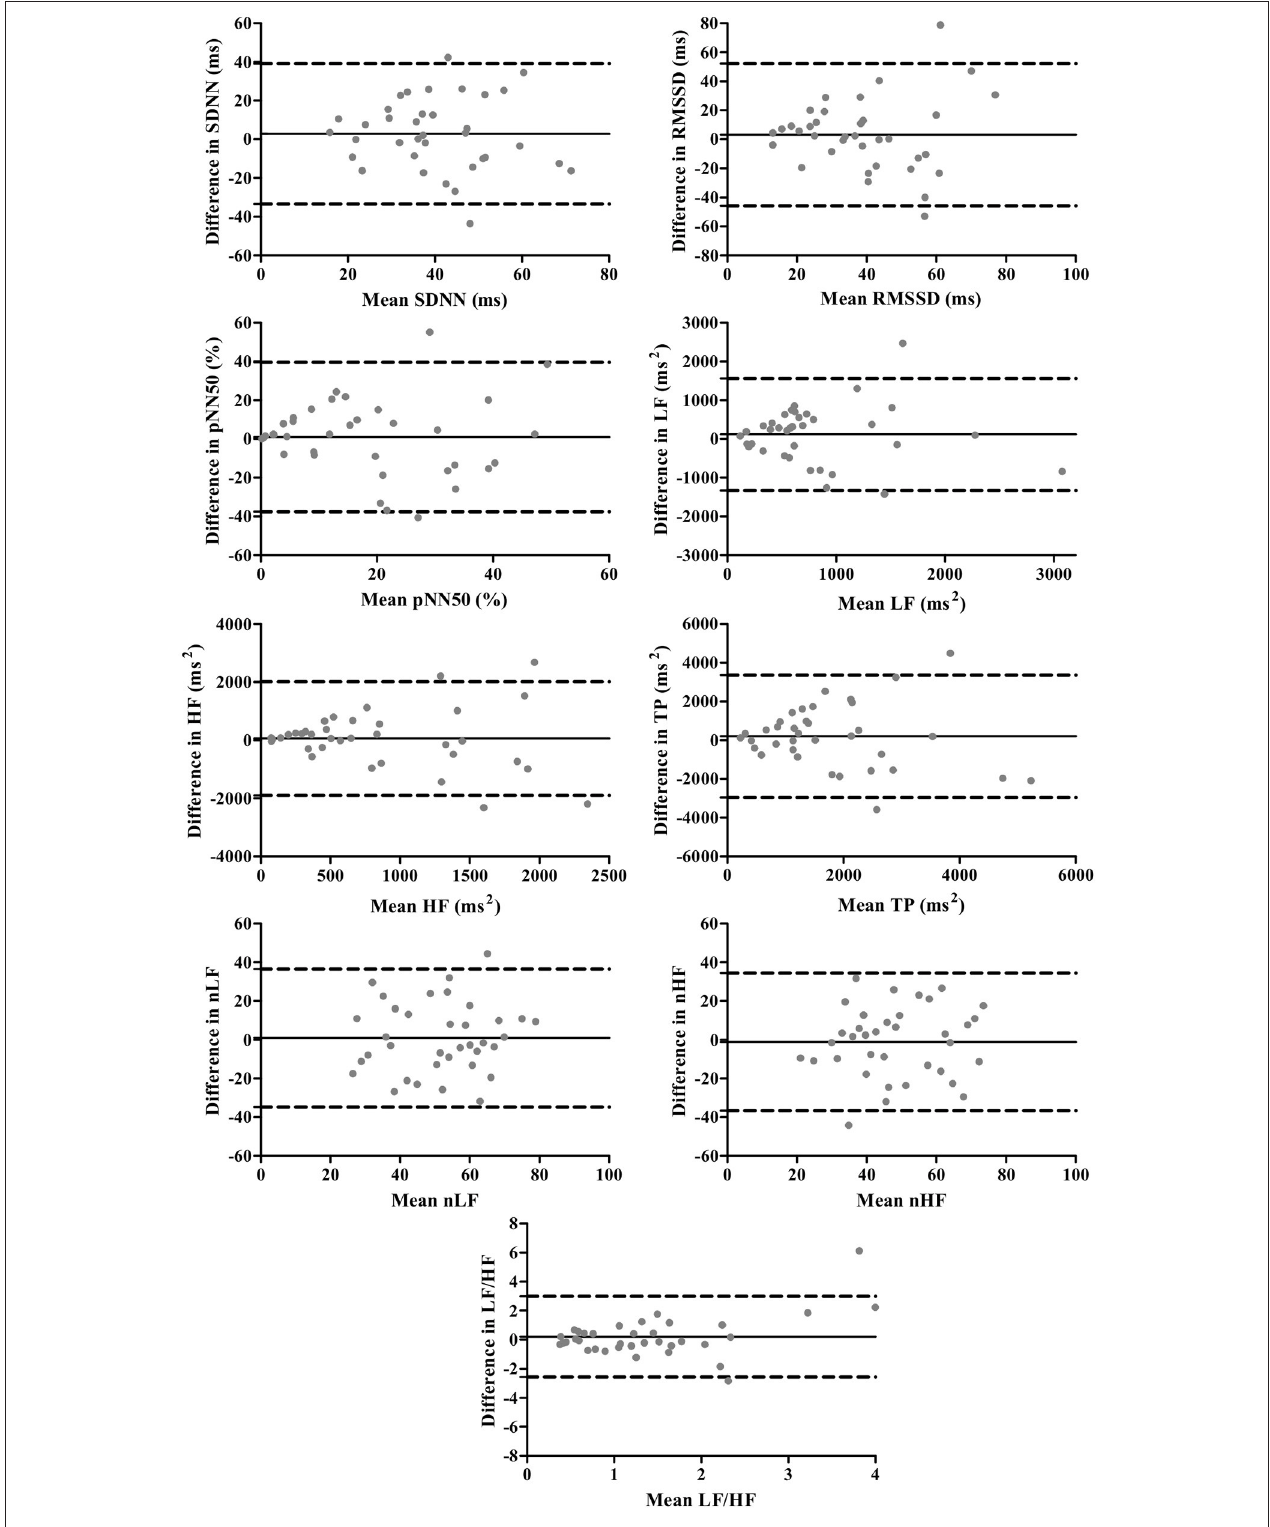
FIGURE 1 | Bland-Altman plots for standard HRV parameters. The solid lines indicate the bias, and dotted lines are the 95% limits of agreement ( ± 1.96 SD ).